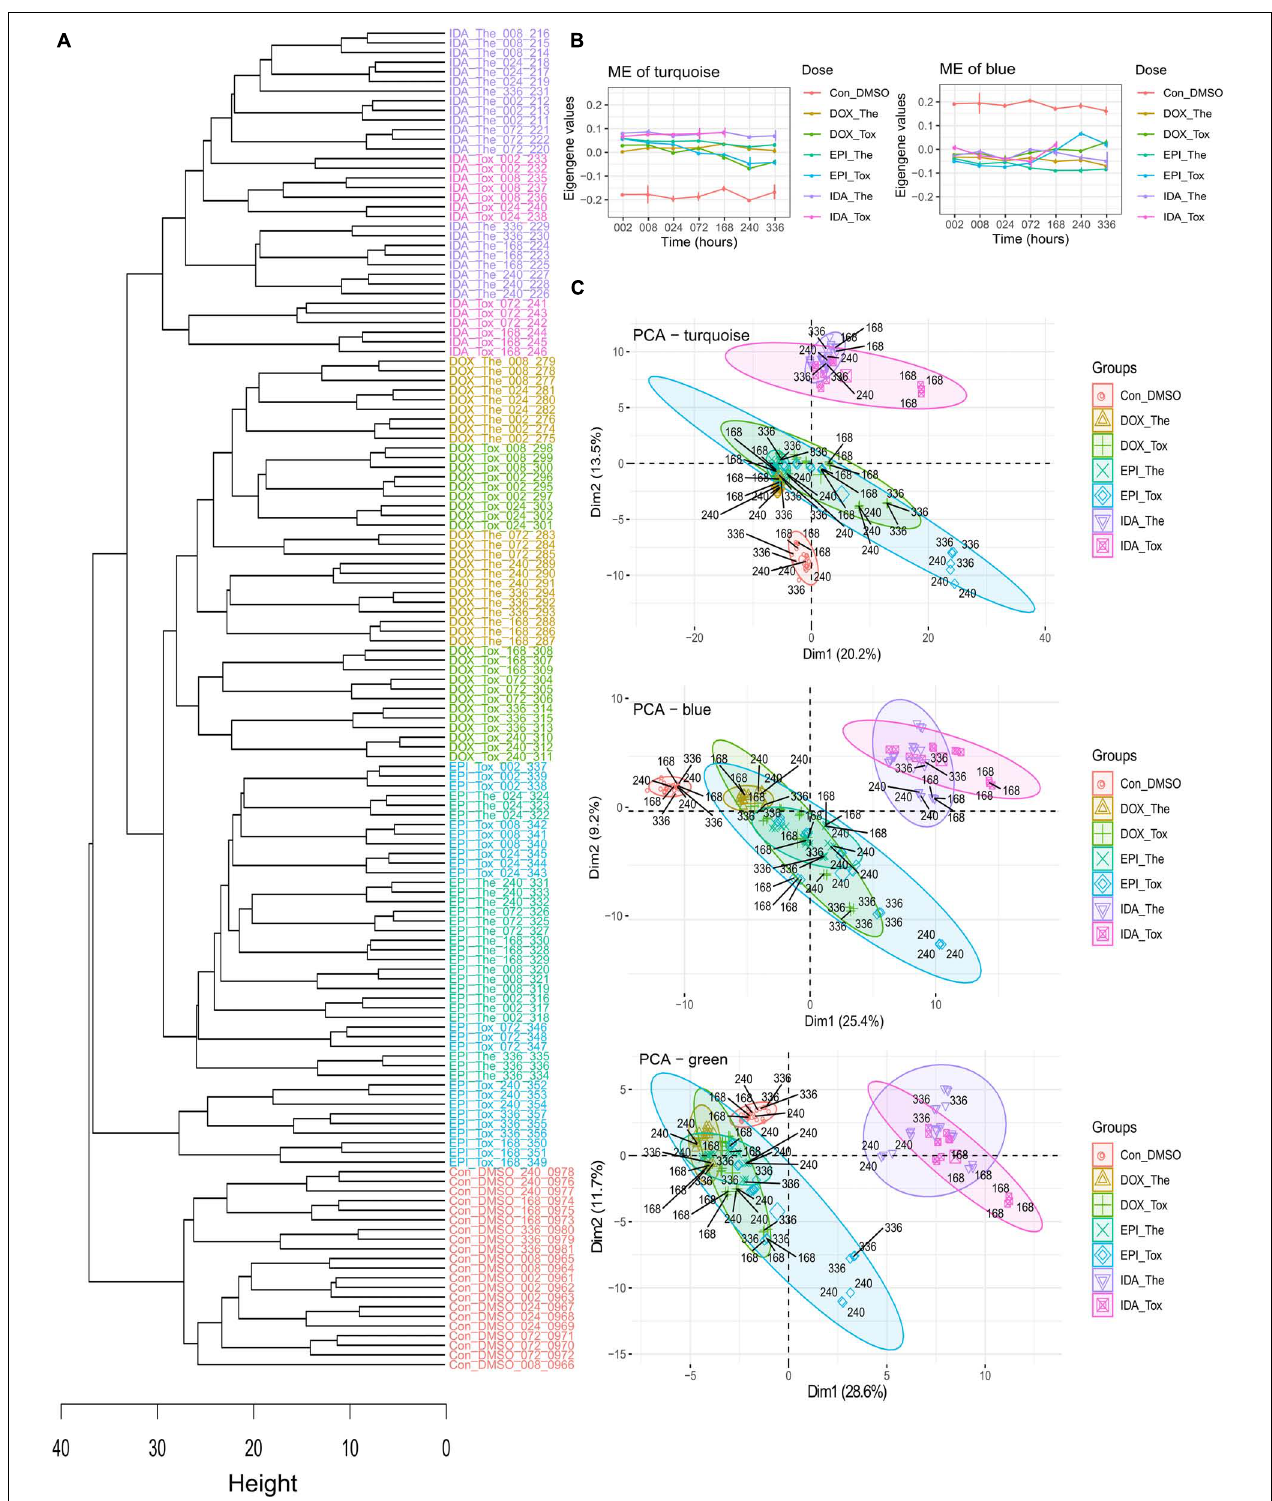
FIGURE 3 | The in vitro cardiac microtissue proteomics data analysis. (A) The hierarchical clustering tree is based on the in vitro protein expression values. The control, epirubicin, doxorubicin, and idarubicin samples were colored by red, blue, green, and purple, respectively. (B) The module eigengene (ME) values in WGCNA modules. (C) The PCA of the modules turquoise, blue, and green. Drugs: DOX, doxorubicin; EPI, epirubicin; IDA, idarubicin. Treatment doses: The, therapeutic dose; Tox, toxic dose. Exposure period: 002: 2 h exposure, 008: 8 h exposure, 024: 24 h exposure, 072: 72 h exposure, 168: 168 h exposure, 240: 240 h exposure, 336: 336 h